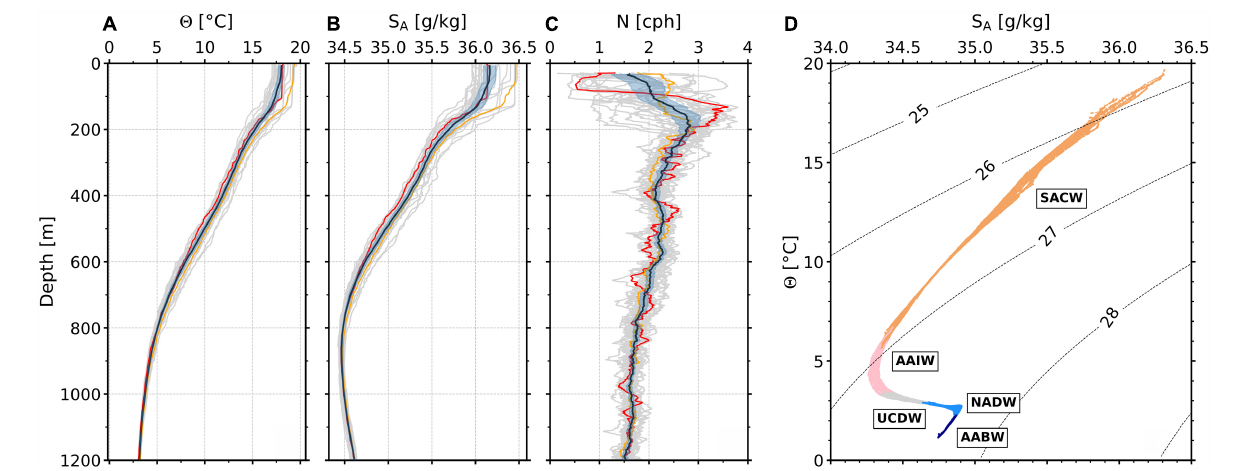
FIGURE 2 | Water properties from 22 GO-SHIP 2011 CTD casts (yellow dots in Figure 1 ). (A) Conservative temperature, (cid:50) , as a function of depth. Black line = average profile; gray lines = individual profiles; blue patch = 95% confidence interval; and red/orange lines = average profiles of CTDs with red/orange edges ( Figure 1 ). (B) Absolute salinity, S A , as a function of depth. (C) Buoyancy frequency, N, as a function of depth. [cph = cycles per hour]. (D) Conservative temperature ( (cid:50) ) – Absolute salinity (S A ) diagram. Points colored according to the water mass definition of Hernández-Guerra et al. (2019). Orange dots = South Atlantic Central Water (SACW); pink dots = Antarctic Intermediate water (AAIW); gray dots = Upper Circumpolar Deep Water (UCDW); blue dots = North Atlantic Deep Water (NADW); dark blue dots = Antarctic Bottom Water (AABW). Labeled dotted lines = potential density anomaly